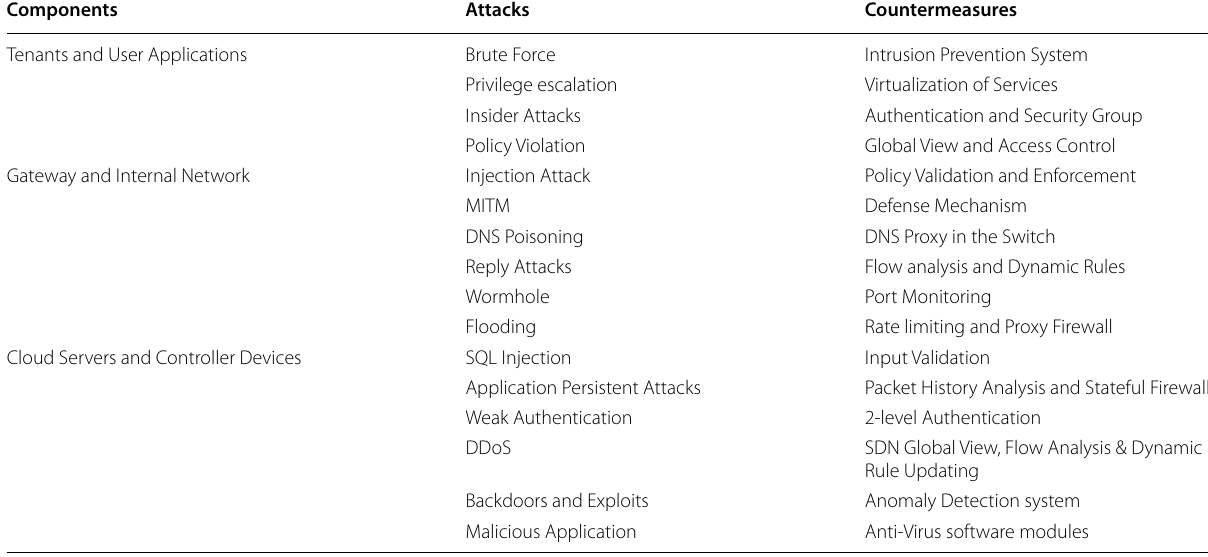
Table 11 List of attacks and countermeasures Components